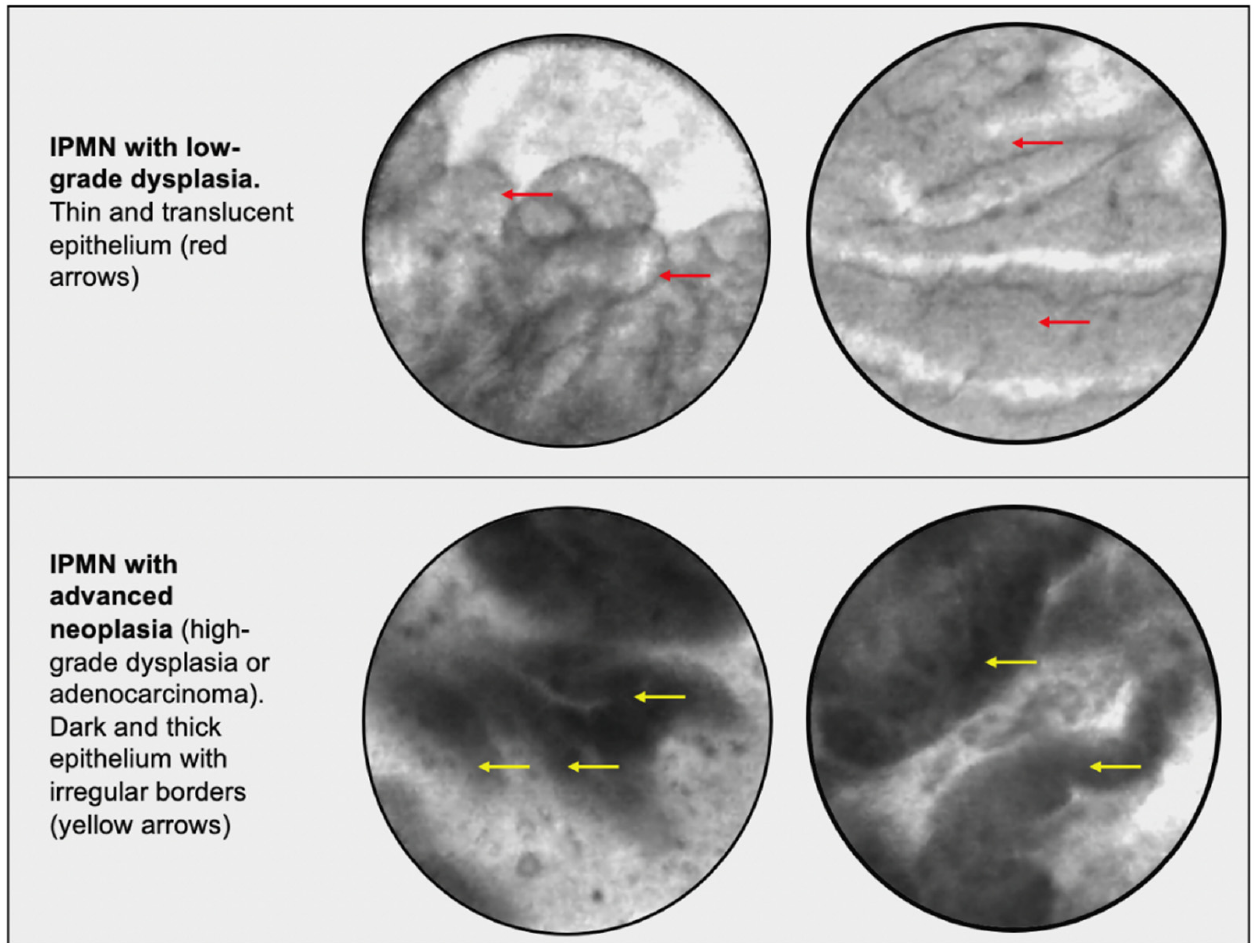
Figure 2. A comparison of EUS-nCLE images. Top panel : IPMNs with low grade dysplasia. The thin and translucent epithelium is noted by red arrows on EUS-nCLE images. Bottom panel : IPMN with high grade dysplasia. The thicker and darker epithelium is noted by yellow arrows.